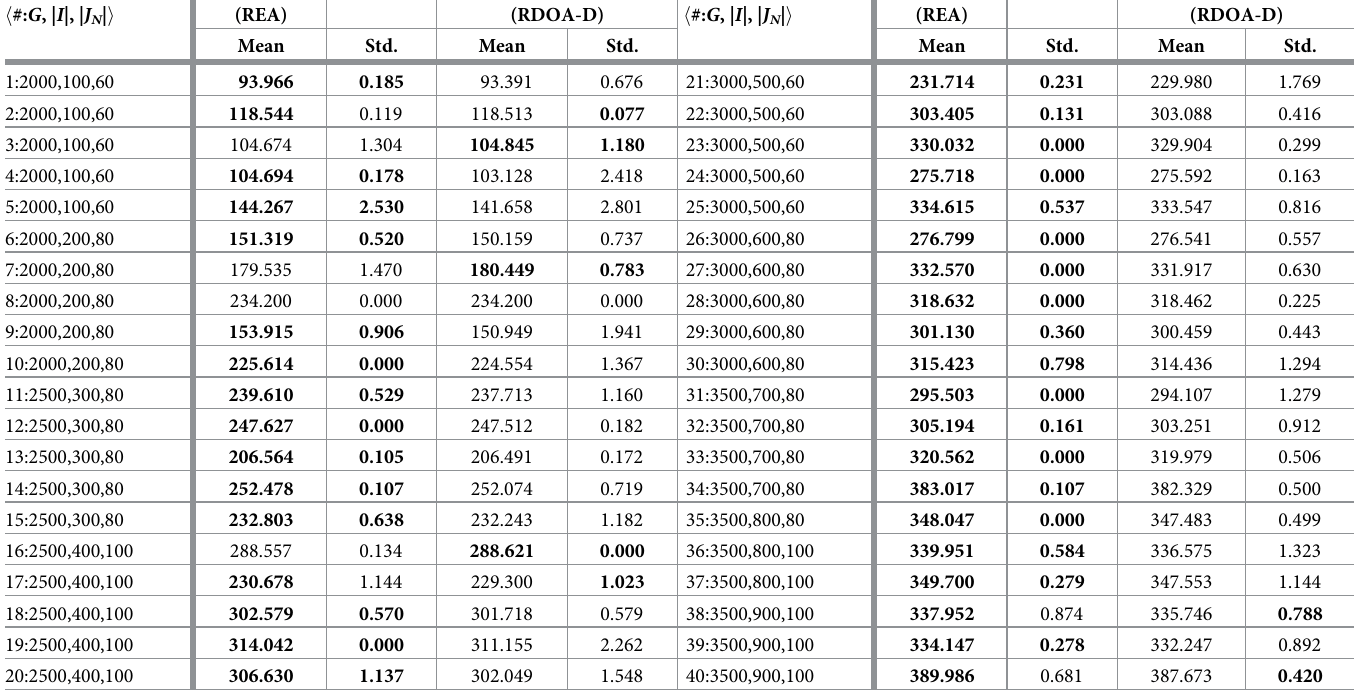
Table 3. Performance comparison of (REA) and